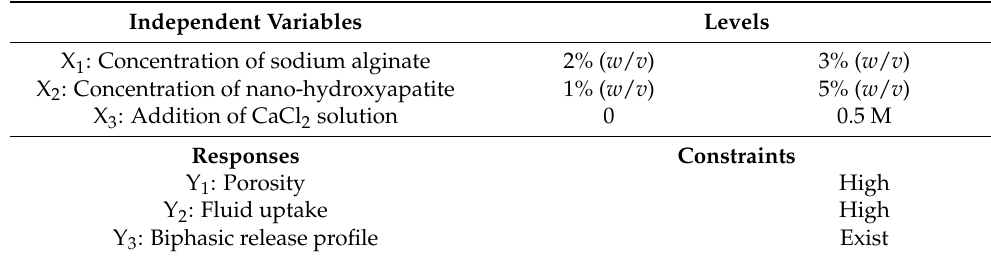
Table 1. Variables and responses with their levels and constraints for the 2 3 factorial